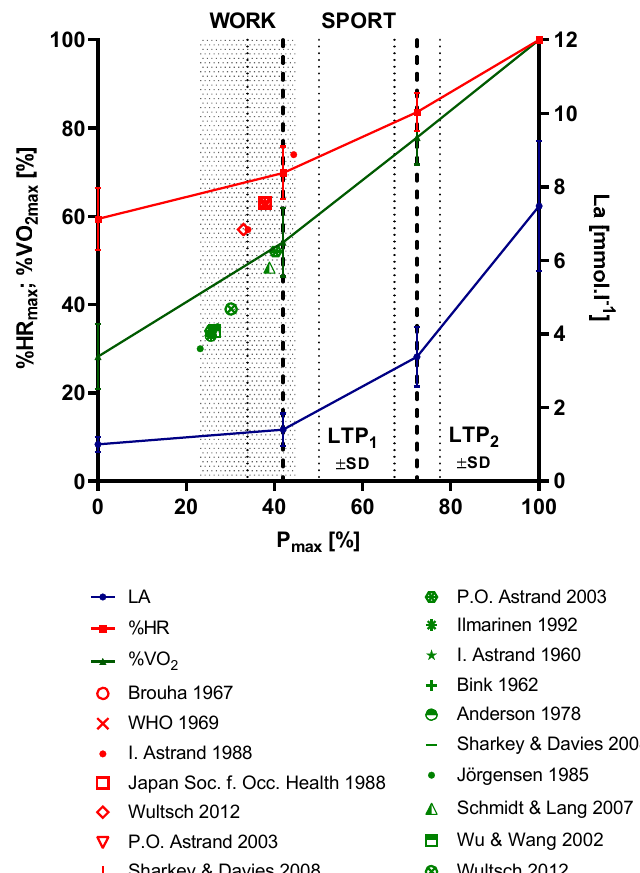
Figure 5. Published limits for heart rate (HR) as a percentage of the maximum HR (% HR max , red) and oxygen uptake as a percentage of the maximum oxygen consumption (% VO 2 max , green) for heavy occupational work related to cycle ergometer exercise reference data. Lactate thresholds (LTP 1 , LTP 2 ) were determined according to Hofmann et al. [29], from original data [5]. Workloads below LTP 1 represent occupational work, strain levels above LTP 1 are defined as sport activities.